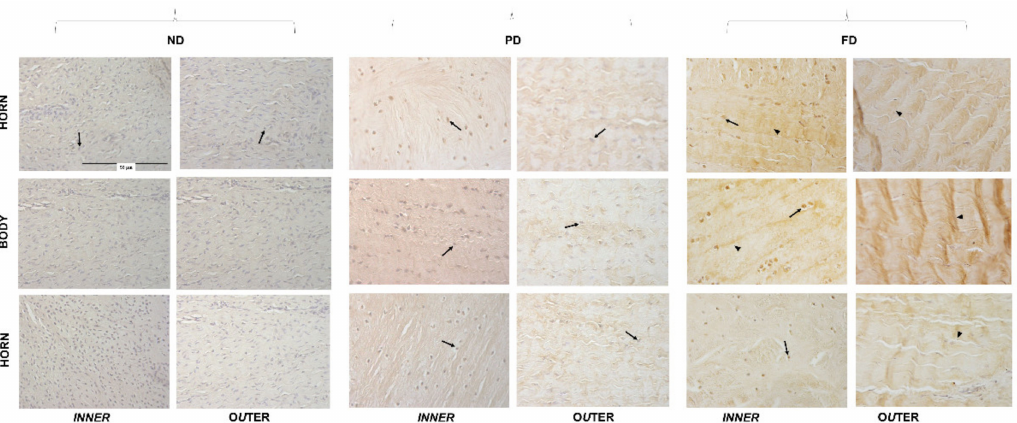
Figure 4. Aggrecan immunostaining in the inner and outer regions of the anterior horn, body, and posterior horn of ND, PD, and FD. Arrows: nuclei, arrowheads: fibers. All the images have the same scale bar (located in the first image: 50 µ